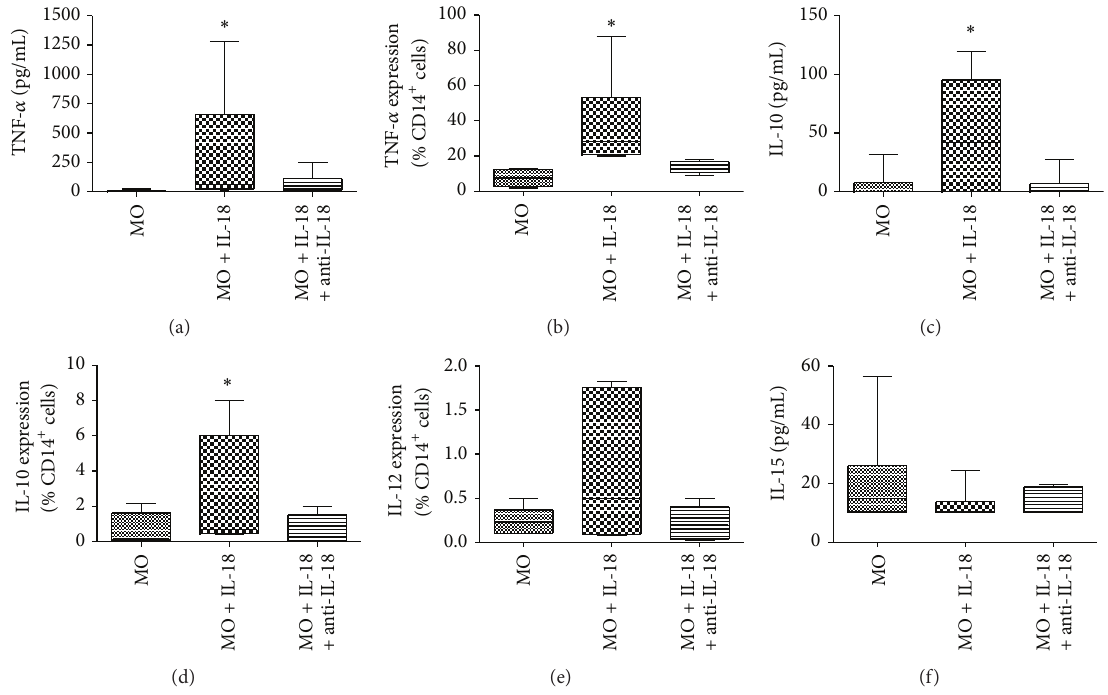
Figure 2: Production of TNF- 𝛼 ((a) and (b)), IL-10 ((c) and (d)), IL-12 (e), and IL-15 (f) in CD14 + monocytes treated with IL-18 (100ng/mL) or IL-18 (100ng/mL) plus anti-IL-18 (0,5 𝜇 g/mL), for 18 hours in culture supernatants, evaluated by ELISA ((a), (c), and (f)), and intracellular staining, by flow cytometry ((b), (d), and (e)). Box-and-whisker plot showing data distribution of 15 healthy subjects tested. Horizontal lines represent the median values; boxes represent the 25th to 75th percentiles and vertical lines the 10th to 90th percentiles. ∗ Statistical significance between groups is indicated ( 𝑃 < 0.05 × other